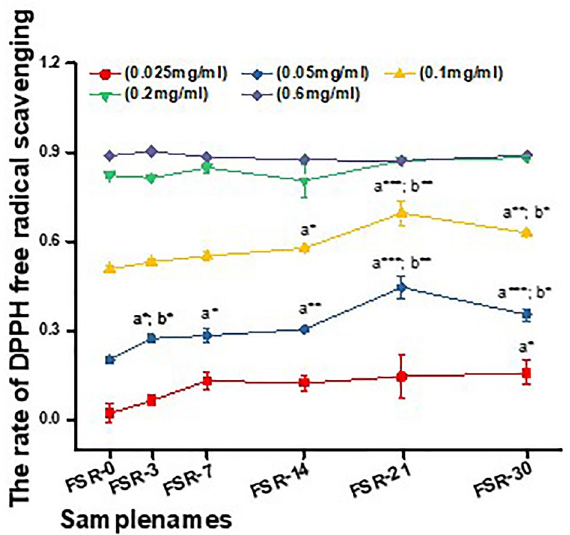
Figure 2. Effects of fermentation time and concentration of FSR on DPPH radical scavenging activity. Each value represents the mean ± SD ( n = 3). Different numbers of asterisks represent different levels of significance from one-way ANOVA: a, compared with FSR-0; b, compared with the previous sample; * P < 0.05; ** P < 0.01; *** P < 0.001.